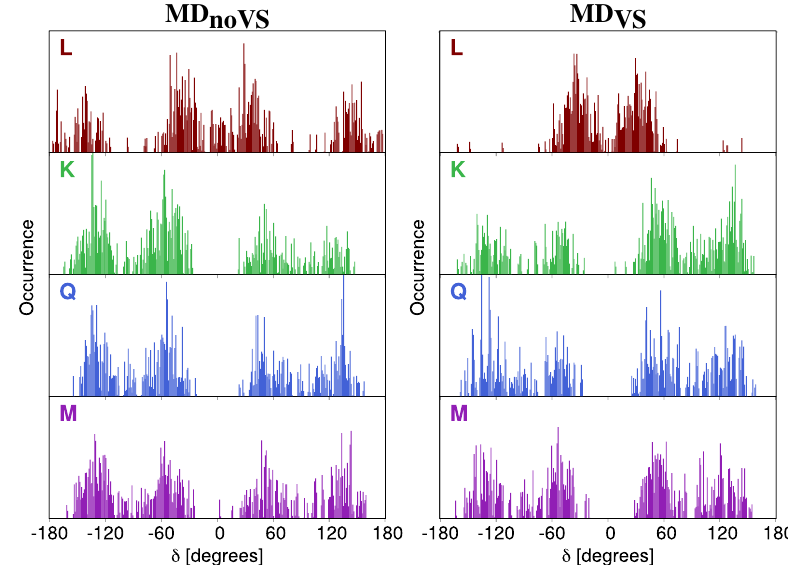
Figure 4. DDF of δ dihedral angle of L (brown), K (green), Q (blue) and M (purple) as obtained from MD noVS ( left ) and MD VS ( right